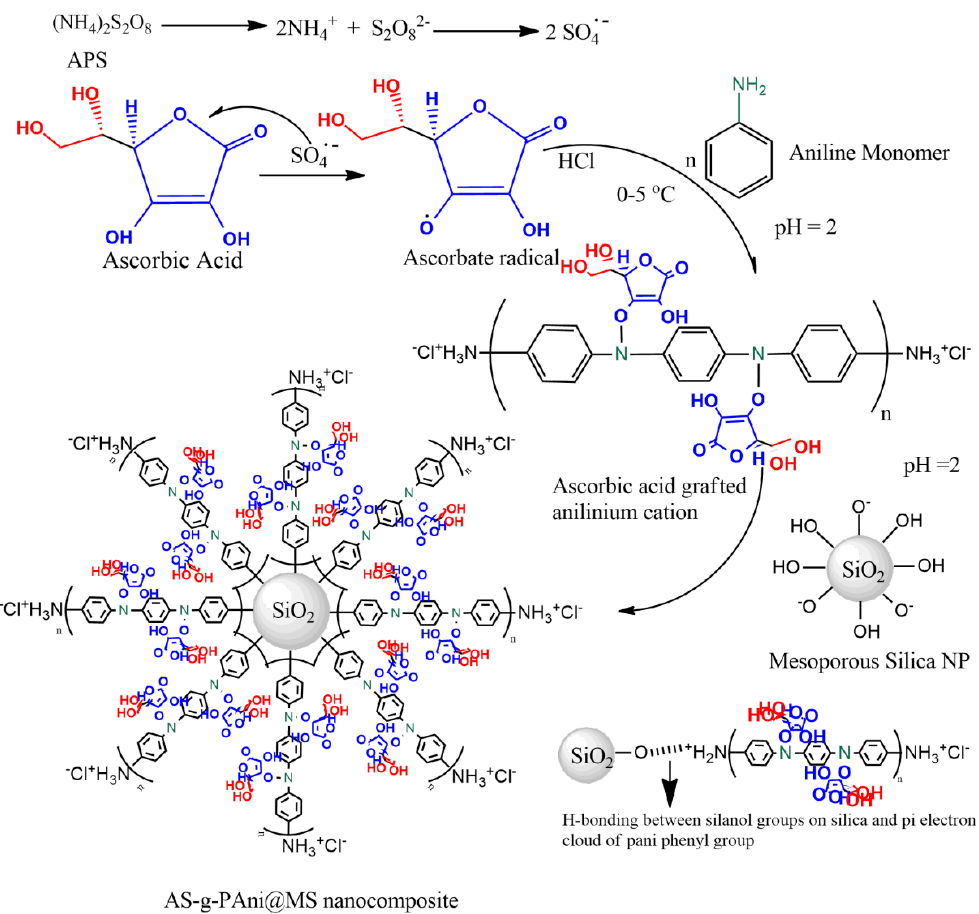
Figure 1. Synthesis scheme for AS-g-PAni@MS nanocomposite material through in situ free radical polymerization reaction.